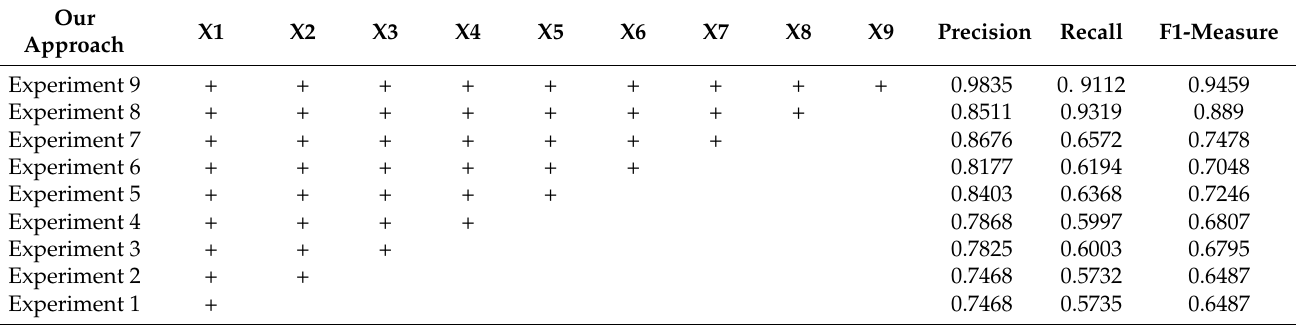
Table 3. The outcomes obtained from the experimentations carried out the feature